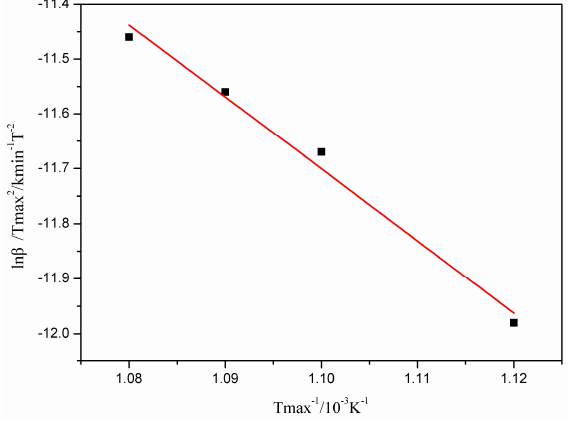
Figure 8. Scatter plots and linear regression curves of 1/ T max − ln β / T max2 .